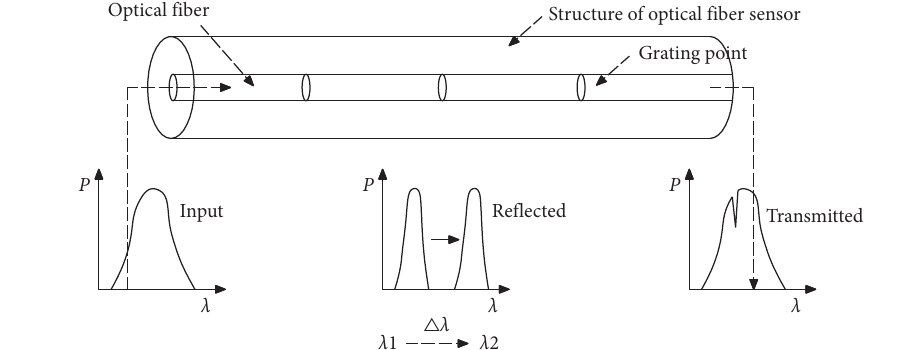
Figure 1: Illustration of FBG sensing